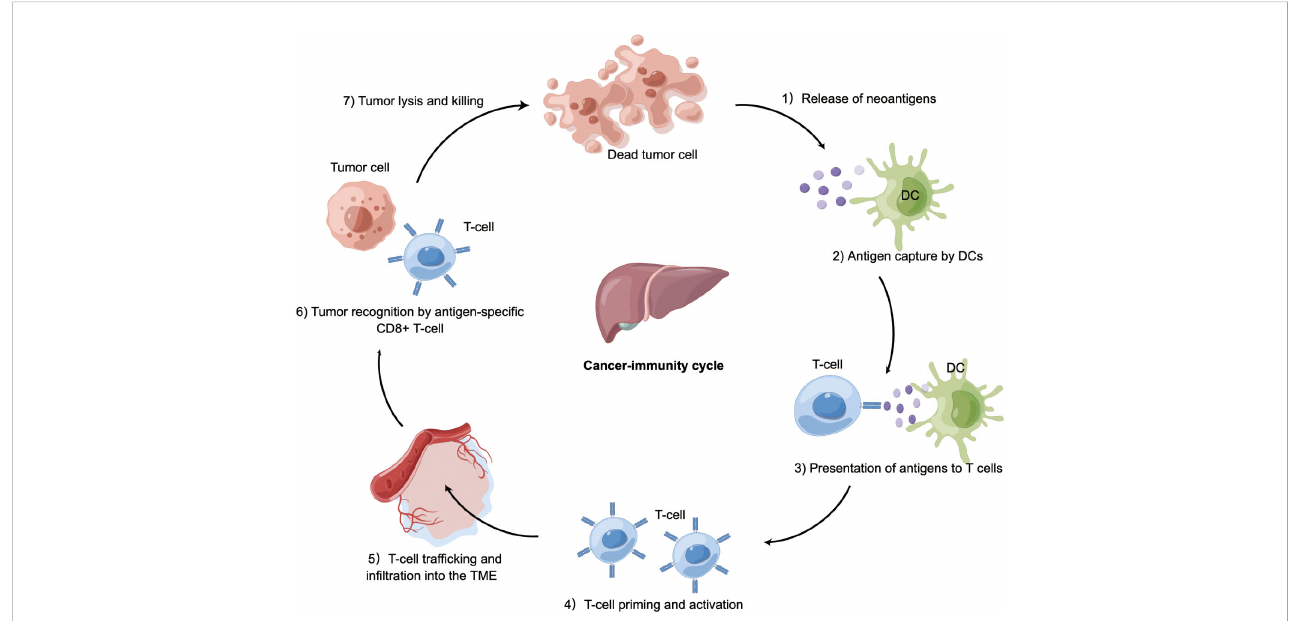
FIGURE 2 Cancer-immunity in HCC. Tumor cells release antigens into the tumor microenvironment due to necrosis or treatment. Dendritic cells capture cancer antigens and traf fi c to the lymphoid organs where they present antigens to T cells, followed by T-cell priming and activation. These activated T cells migrate and in fi ltrate into HCC tissue. CD8 + T cells recognize HCC cells via T cell receptor. The fi nal step is T cell-mediated killing of tumor cells, allowing more cancer-speci fi c antigens to release. Tumor can perturb the processes mentioned above to occur immune evasion. DC, dendritic cell; TME, tumor microenvironment; HCC, hepatocellular